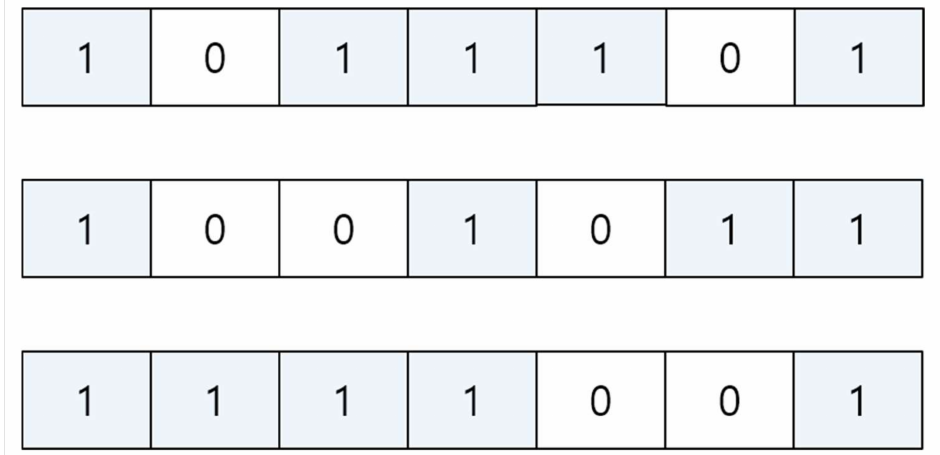
Figure 2. A simple example of three vectors whose supports are not included in one